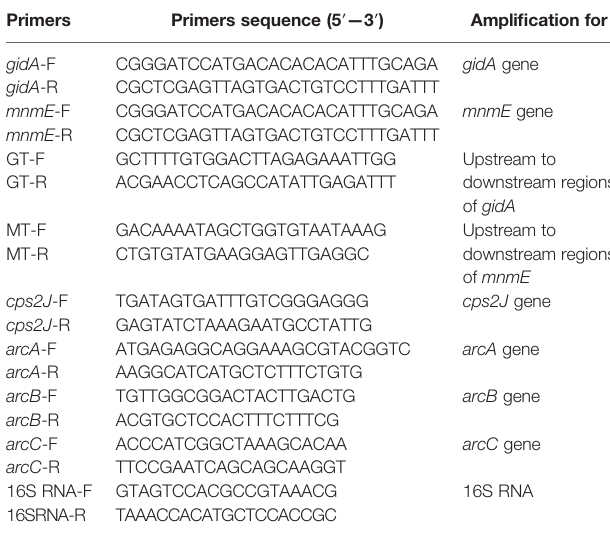
TABLE 2 | Primers used for PCR ampli fi cation and